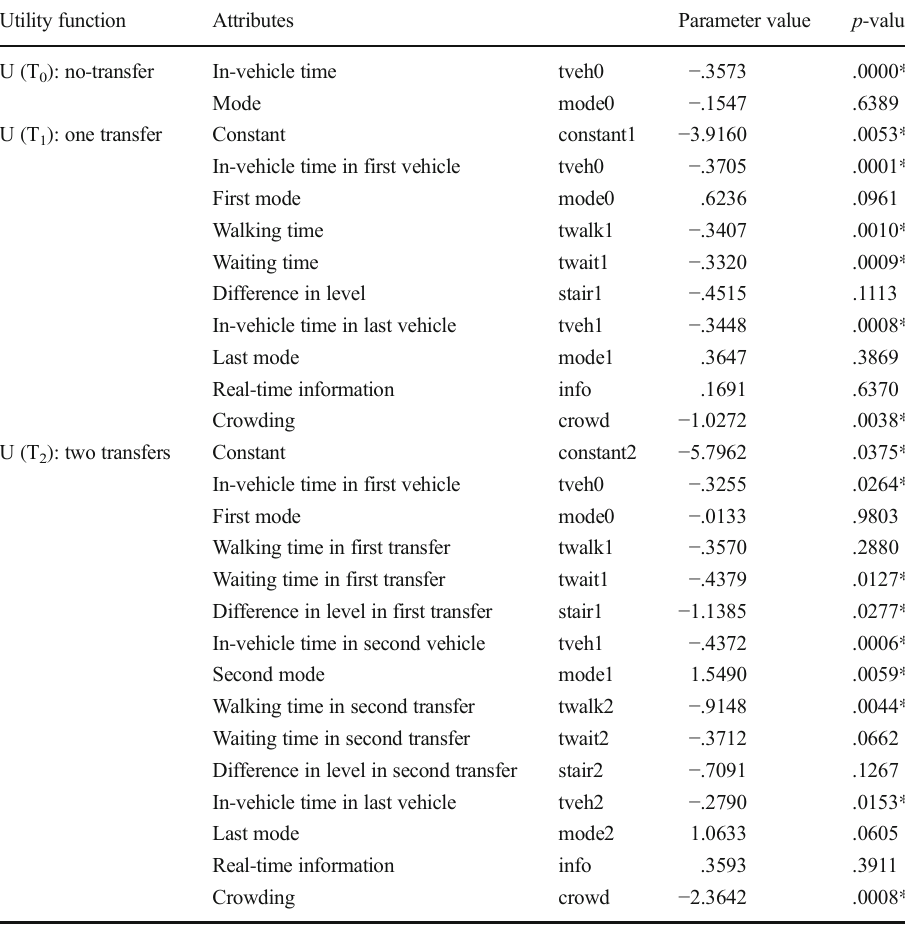
Table 1 Results of the MNL models of utility functions. Pilot